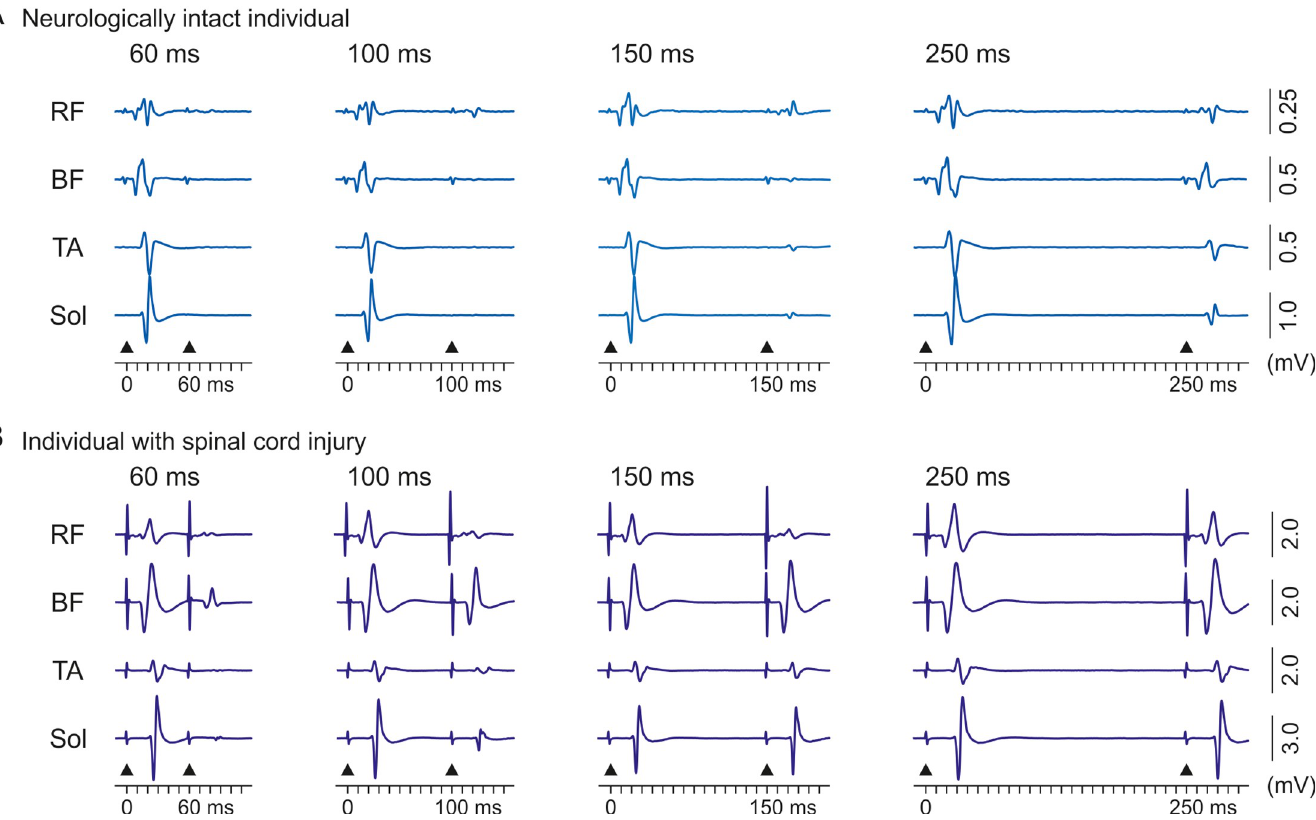
Fig 3. Exemplary PRM reflexes of thigh and lower leg muscles tested by paired-pulse paradigm. PRM reflexes of rectus femoris (RF), biceps femoris (BF), tibialis anterior (TA), and soleus (Sol) for a sub-set of conditioning-test intervals as indicated, derived from (A) a neurologically intact participant and (B) an individual with spinal cord injury (subject 10). Each trace is the average of ten responses. Black arrowheads mark times of stimulus